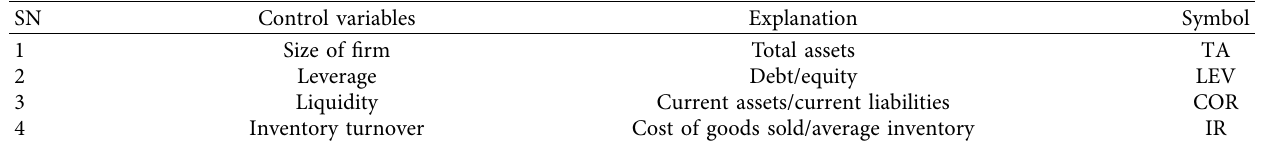
Table 2: Control